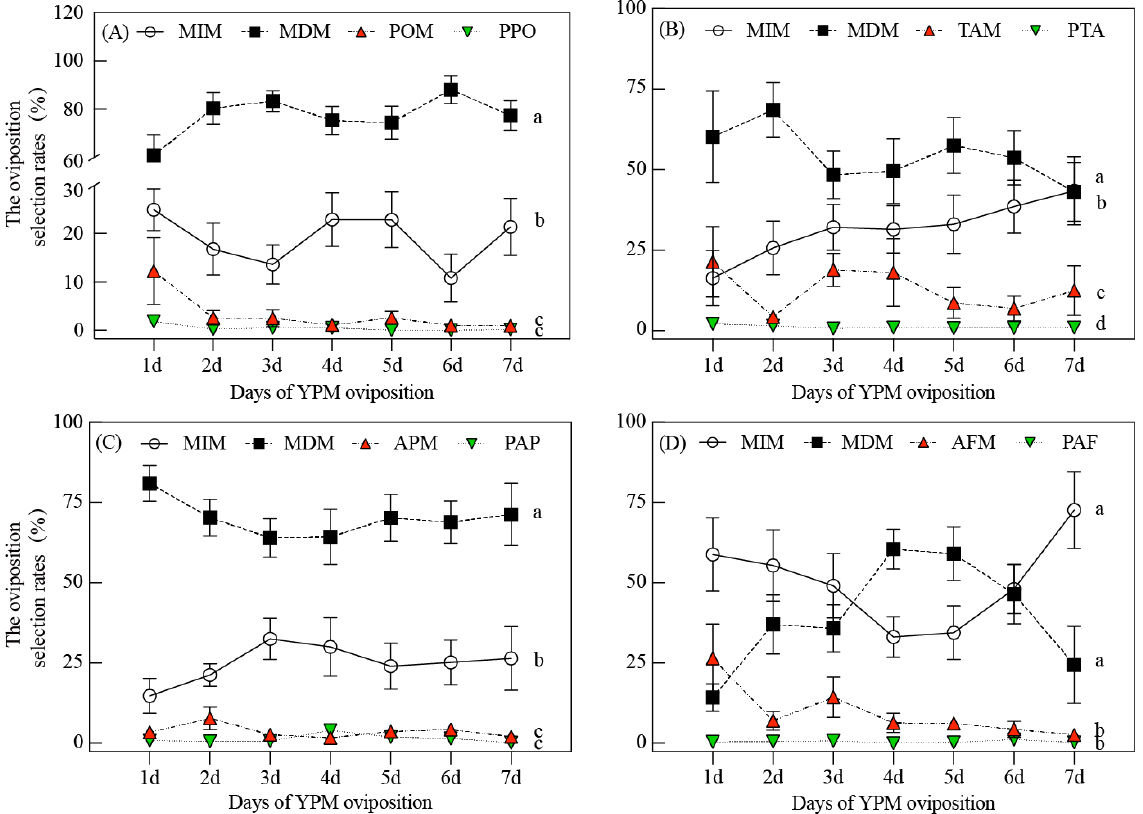
Figure 2. The oviposition selection rates of mated YPM females in oviposition behavioral experiments. P. oxalicum ( A ), T. asperellum ( B ), A. phoenicis ( C ), A. flavus ( D ). 1–7 d: Days of YPM oviposi-